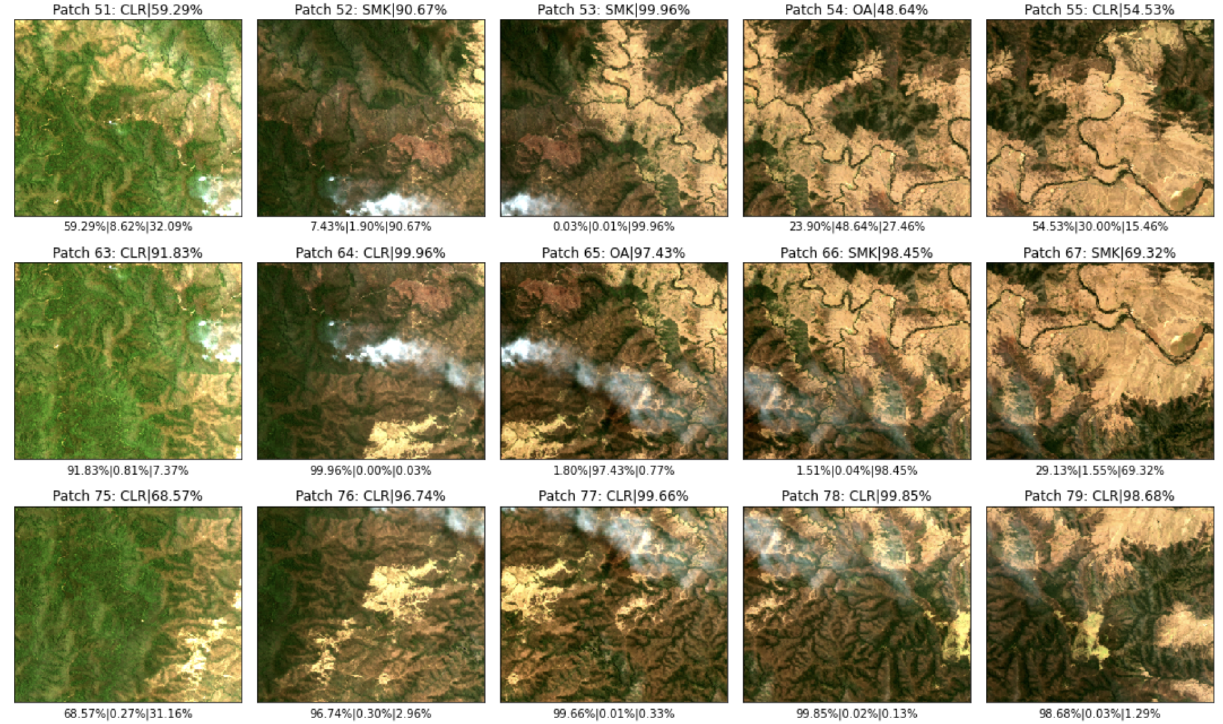
Figure 14. Prediction results of the middle fire smoke area of scene (d) in Figure